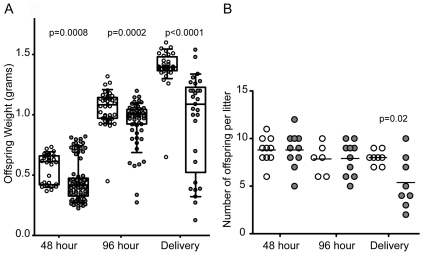
Perinatal outcomes in the presence and absence of maternal UTI.(A) Weight (grams) of each individual offspring from pregnant mice that received sham treatment (white) or experimental UTI (gray) at 48 h (10 mice each cohort), 96 h (10 mice each cohort), and delivery (8 mice each cohort). Box portion of the plot represents 95% of the samples with the range of samples indicated by the external bars; the horizontal bar within the box depicts the median and the mean values are indicated in the text. (B) The number of pups delivered for each mother is depicted. Statistical significance was determined using a two-tailed Mann-Whitney test for internal comparisons of each time point indicated in each panel.